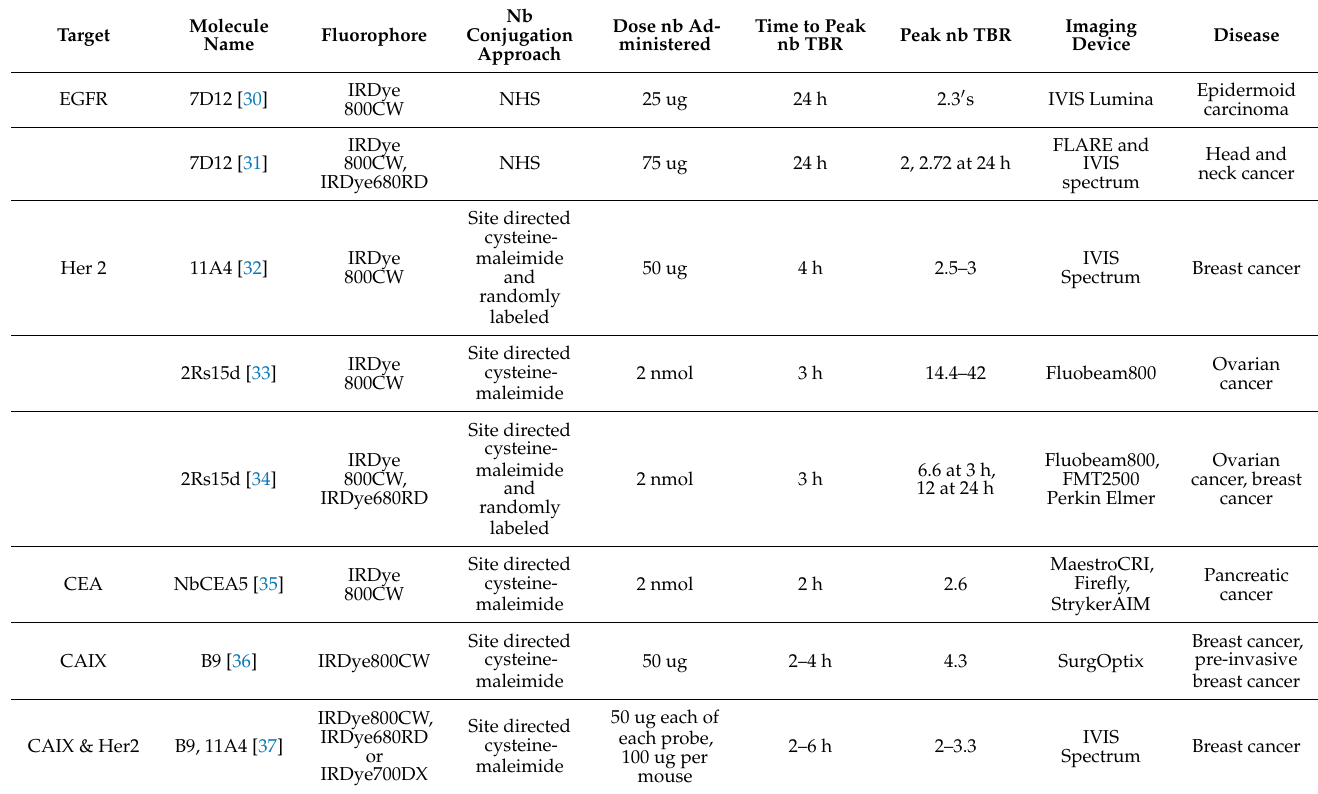
Table 1. A summary of pre-clinical nanobody probes being developed for tumor-specific FGS.